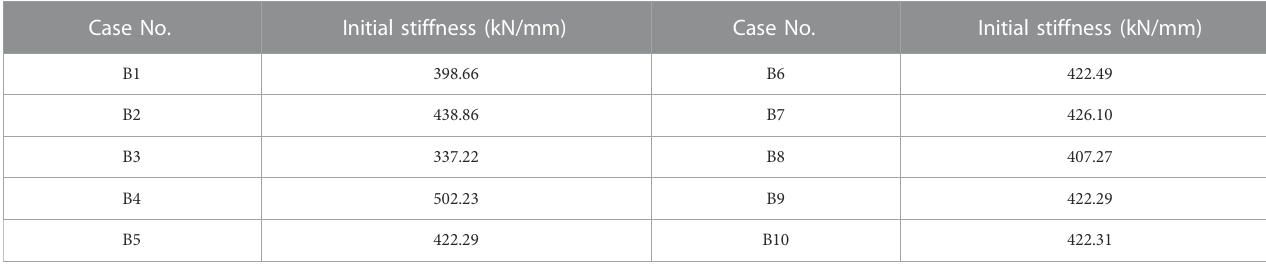
TABLE 2 Initial stiffness of K-joint. Case